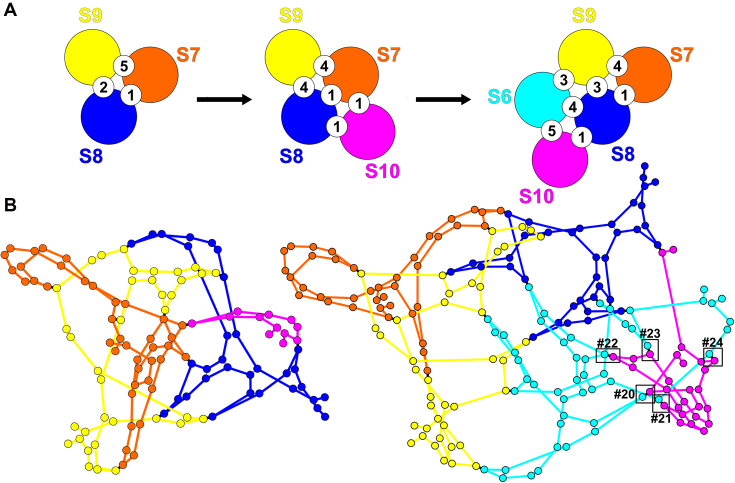
The predicted network of trans interactions. (A) Cartoon illustrating the changing distributions of trans interactions during transition from Stage 1 to Stage 3. (B) The interaction networks at Stages 2 and 3 are illustrated in Gephi; individual segments are colour-coded as in (A), and nodes represent positions of cis or trans interactions.